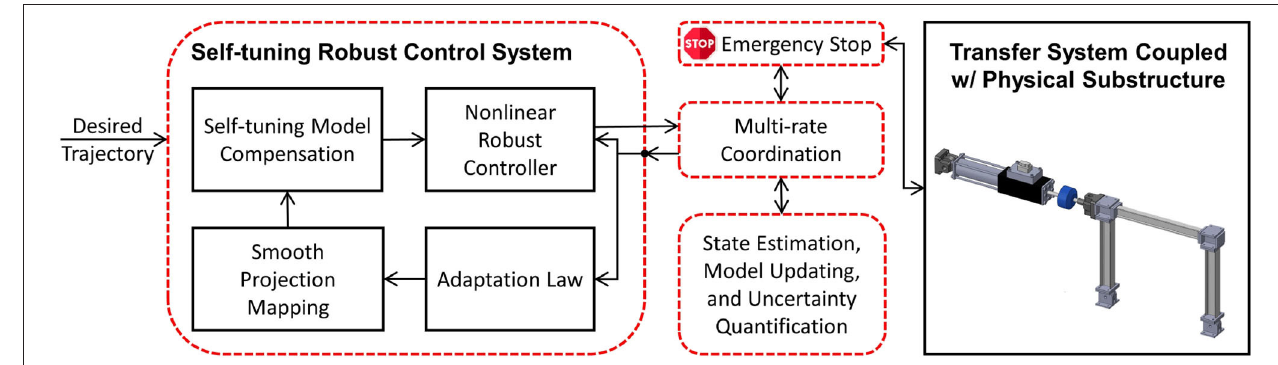
FIGURE 4 | Block diagram of the Self-tuning Robust Control System in REFORM-I.